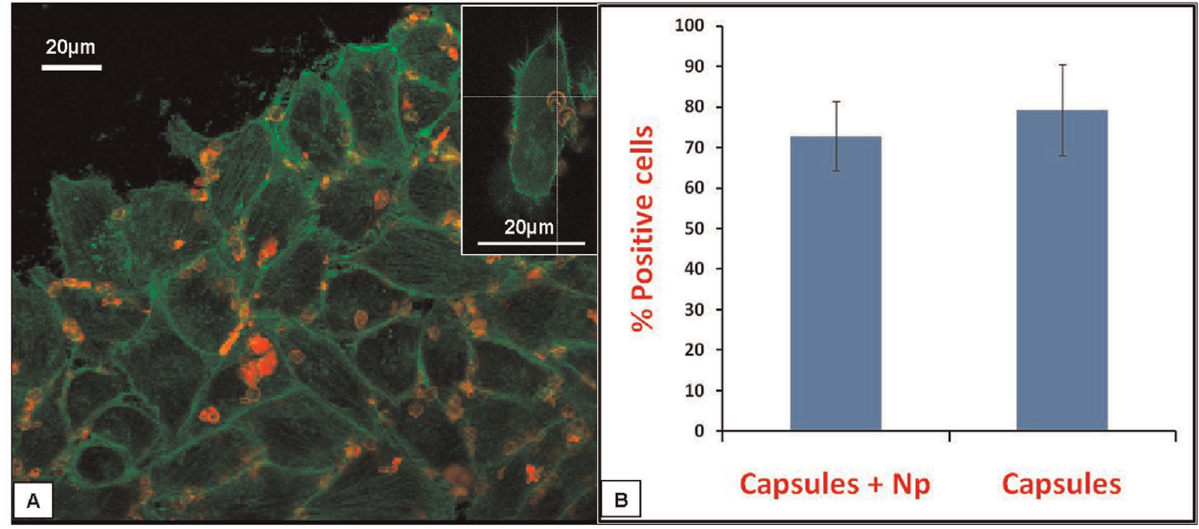
Figure 8. Uptake of nanoparticles-loaded PSS/PAH capsules by HeLa cells. ( a ) Confocal laser scanning microscopy (CLSM) image of HeLa cells after uptake of LaF 3 :Tb 3 + (5%) nanoparticles-loaded PSS/PAH capsule. Inset shows high magnification image of a HeLa cell, which has internalized Au nanoparticles-loaded capsule. Actin cytoskeleton of cells was stained with FITC-Phalloidin (green). The outer PAH layer of the capsules is labeled with RITC (red) and ( b ) efficiency of uptake of Au nanoparticles-loaded PSS/PAH capsules and blank PSS/PAH capsules by HeLa cells as investigated by flow cytometry. Efficiency of uptake is represented by percentage positive cells i.e. cells associated (both internalized and bound) with capsules.